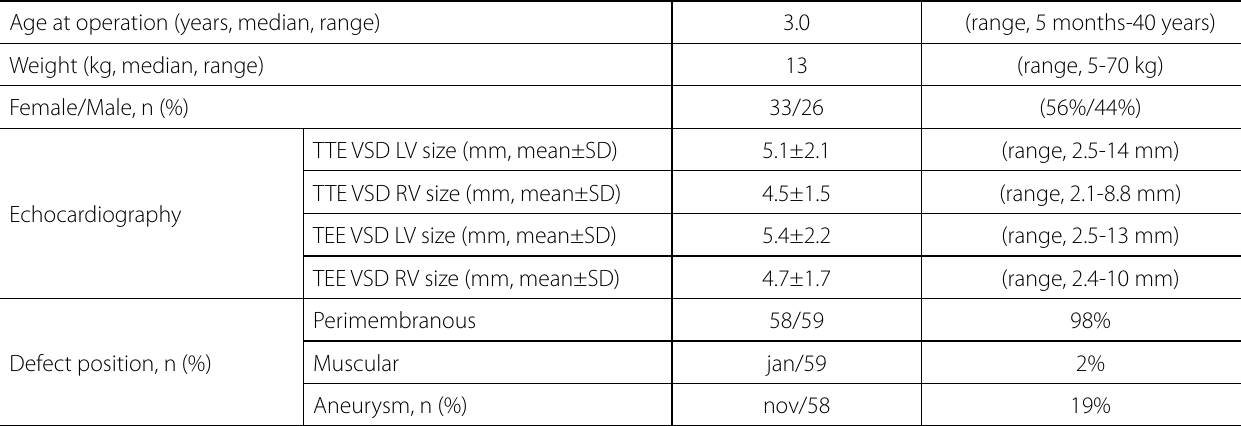
TEE=transesophageal echocardiography; TTE=transthoracic echocardiography; VSD=ventricular septal